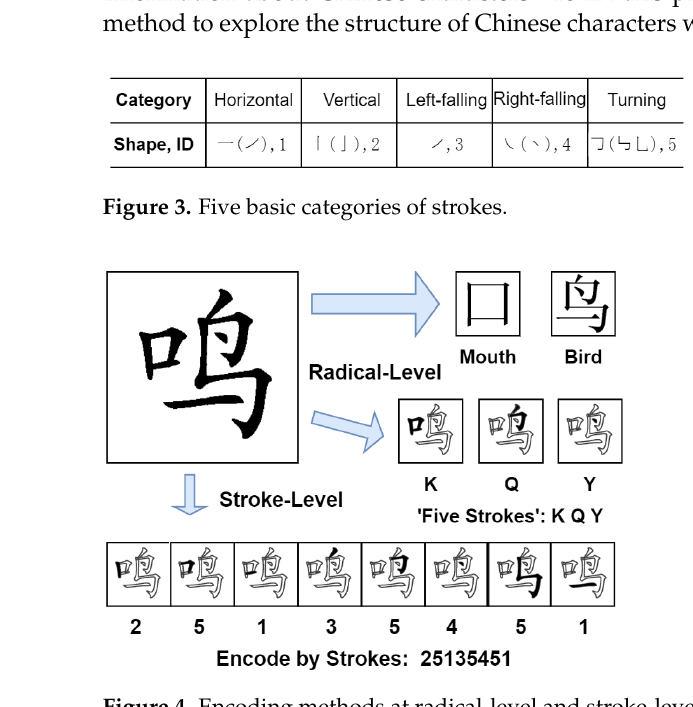
Figure 4. Encoding methods at radical-level and